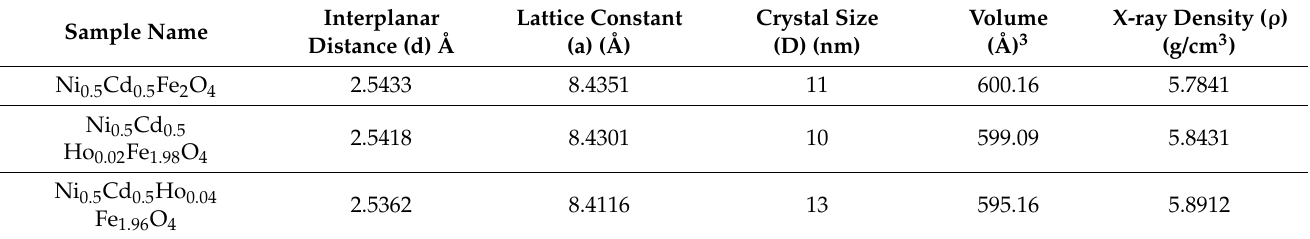
Table 1. XRD parameters of Ni 0.5 Cd 0.5 Ho x Fe 2-x O 4 (x = 0, 0.02, and 0.04) ferrite samples.